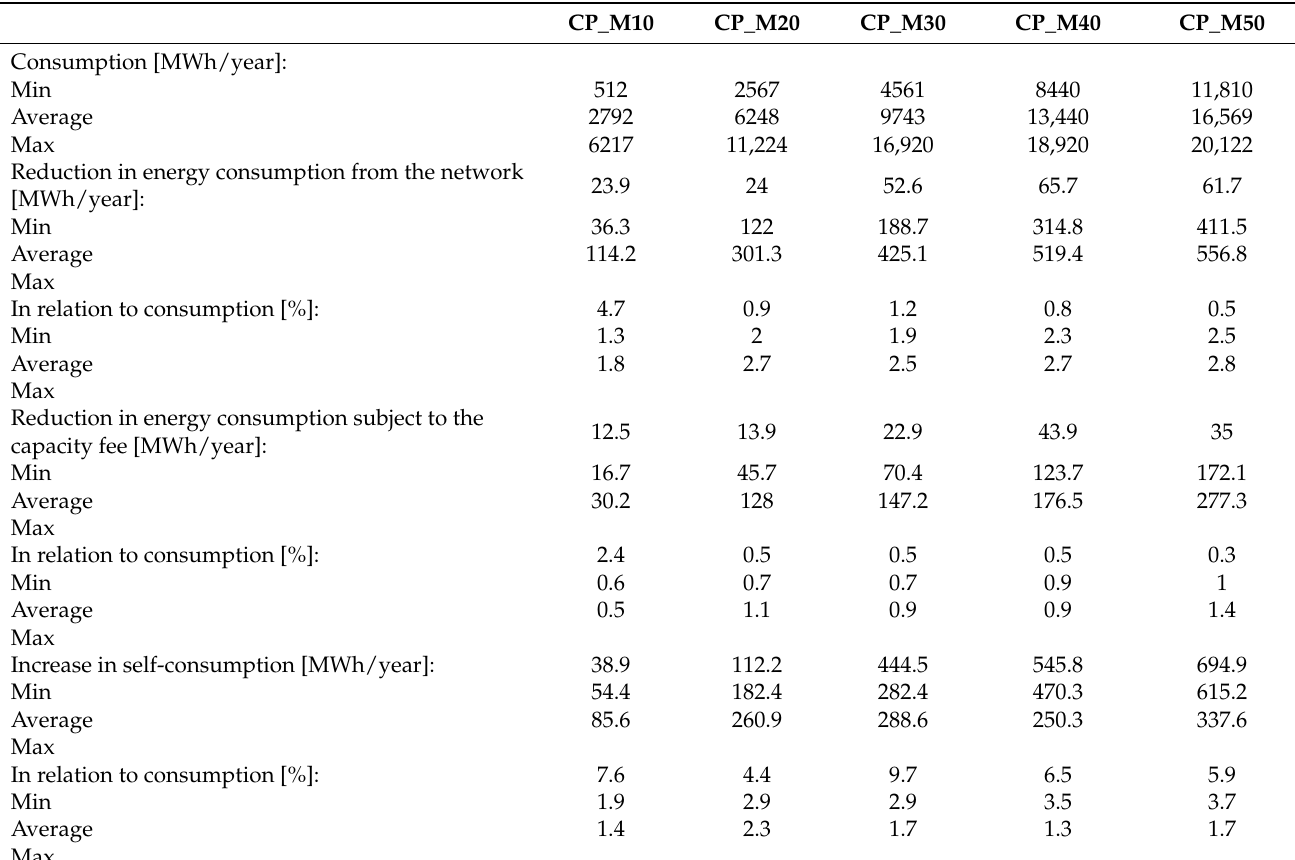
Table 4. Volumetric effects of real energy storage in reference cooperatives with varying numbers of members